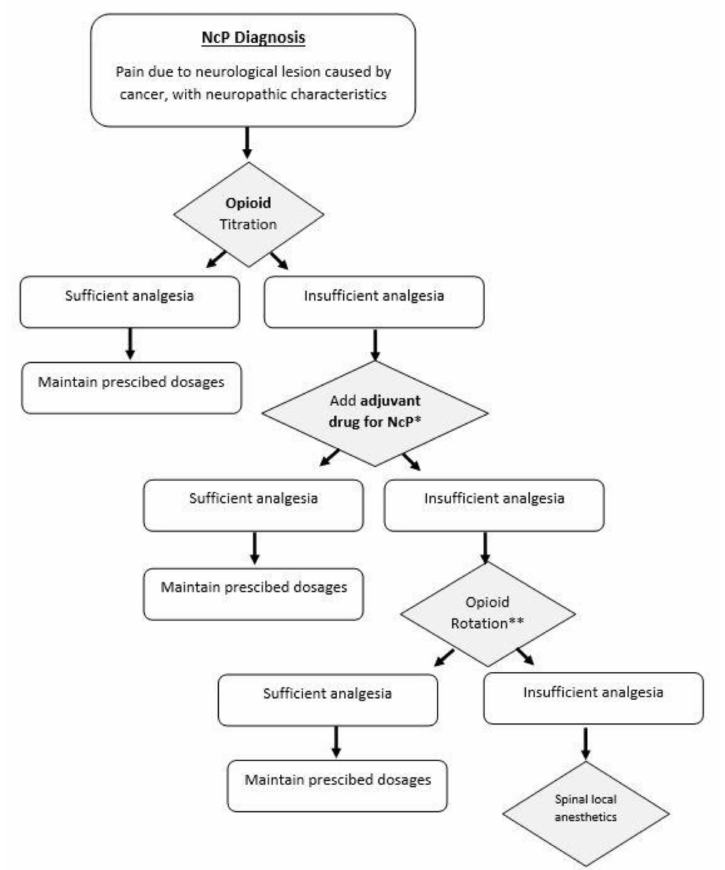
Figure 1. Neuropathic Cancer Pain (NcP) treatment algorithm based on clinical experience. * There is some evidence suggesting the benefit of adjuvant drugs such as gabapentinoids (gabapentin and pregabalin) and antidepressants such as amitriptyline. ** most commonly methadone is used, although requiring caution regarding its titration and dose